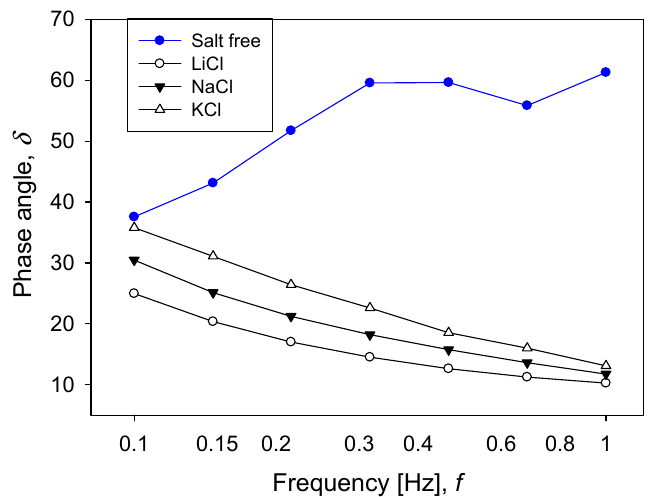
Figure 8. Effect of salt type on phase angle as a function of frequency for silica suspensions formulated at natural pH. Salt concentration is 0.5 M.